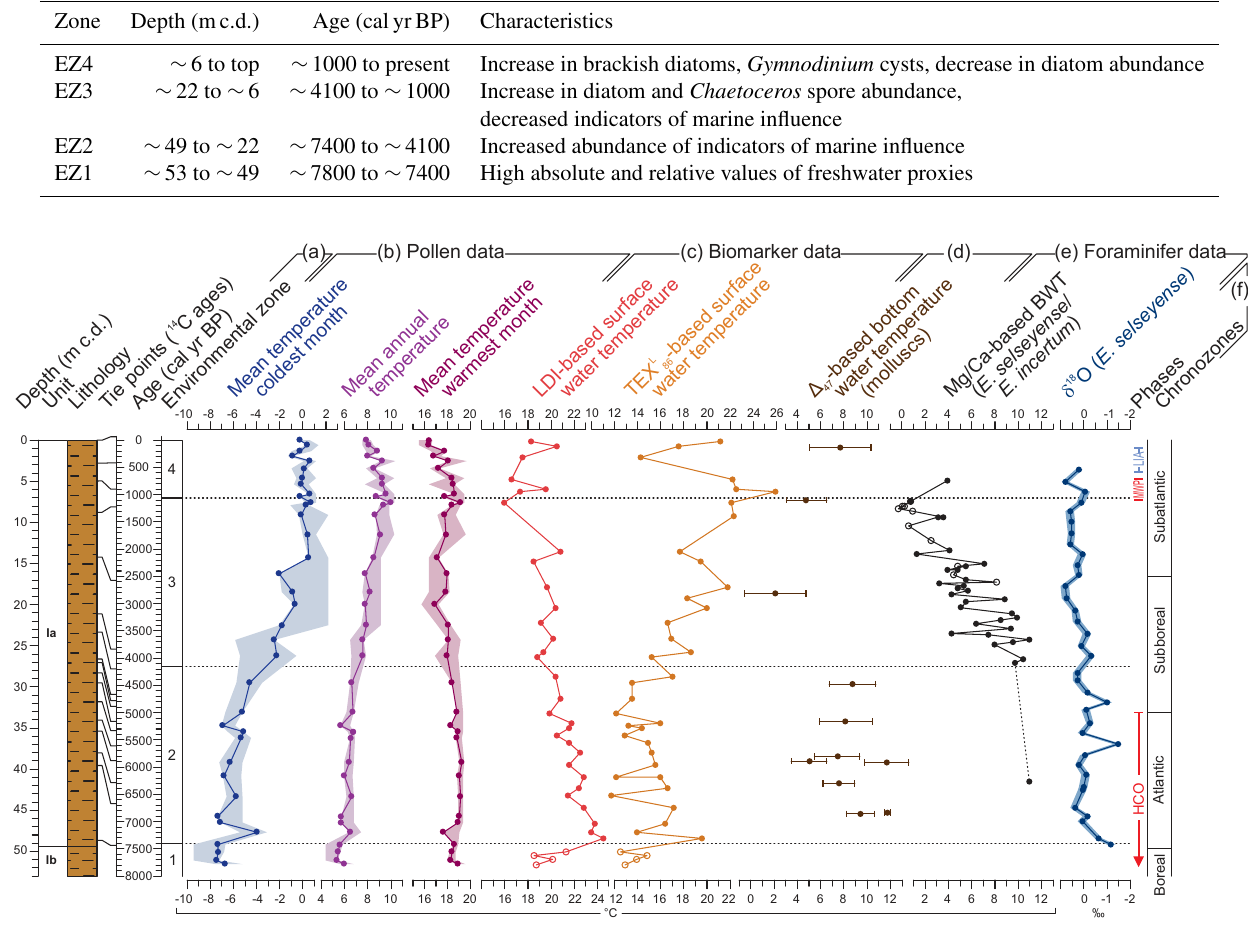
Figure 4. Sedimentological units, lithology (Andrén et al., 2015a), and position of 14 C ages (Van Helmond et al., 2017) vs. depth and IODP Site M0059 temperature proxies plotted vs. age (extrapolated below ∼ 48.64 mc.d.). (a) Environmental zones (EZs) are based on diatom data. (b) Pollen-inferred climate reconstructions are based on the modern analogues technique, with the shaded area reflecting the range of the best 10 analogues. (c) SSTs are reconstructed with the long chain diol index (LDI) and TEX L (d) (cid:49) 47 -inferred temperatures are based on the clumped isotope composition of mollusc shells. (e) Mg / Ca-based bottom water temperature (BWT) is reconstructed using the benthic foraminifera E. selseyense and E. incertum ; stable oxygen isotopes based on the benthic foraminifer E. selseyense . (f) Climate phases and